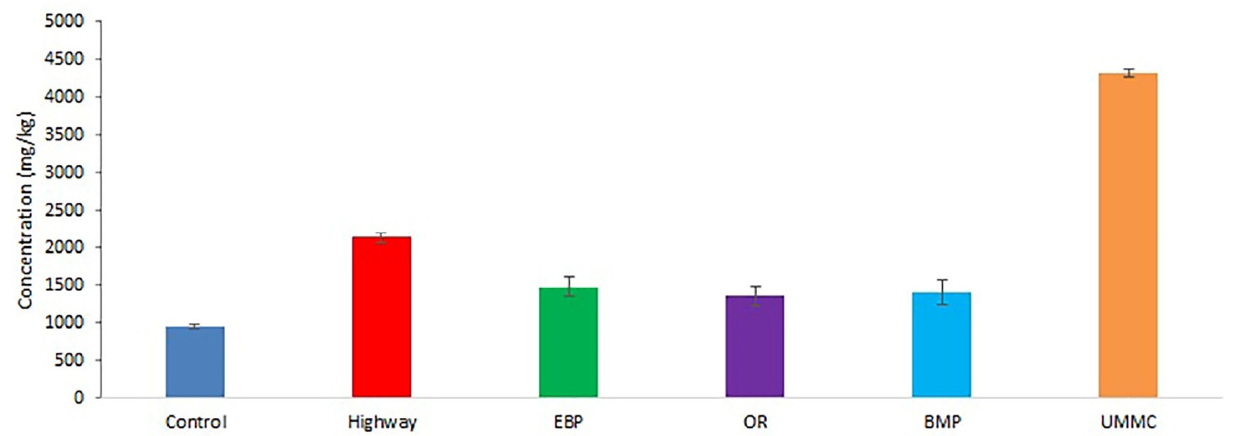
ferrocene and other Fe-containing antidetonant gasoline additives. Fe accumulation above 1000 mg kg − 1 was earlier described in plants from Mn mining areas in China [38], as well as in technogenous areas of the Transbaikal region in Russia [39].